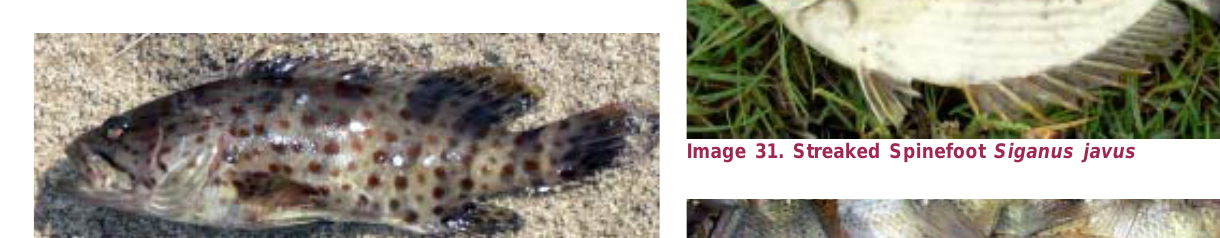
Image 25. Glassy Perchlet Ambassis commersoni